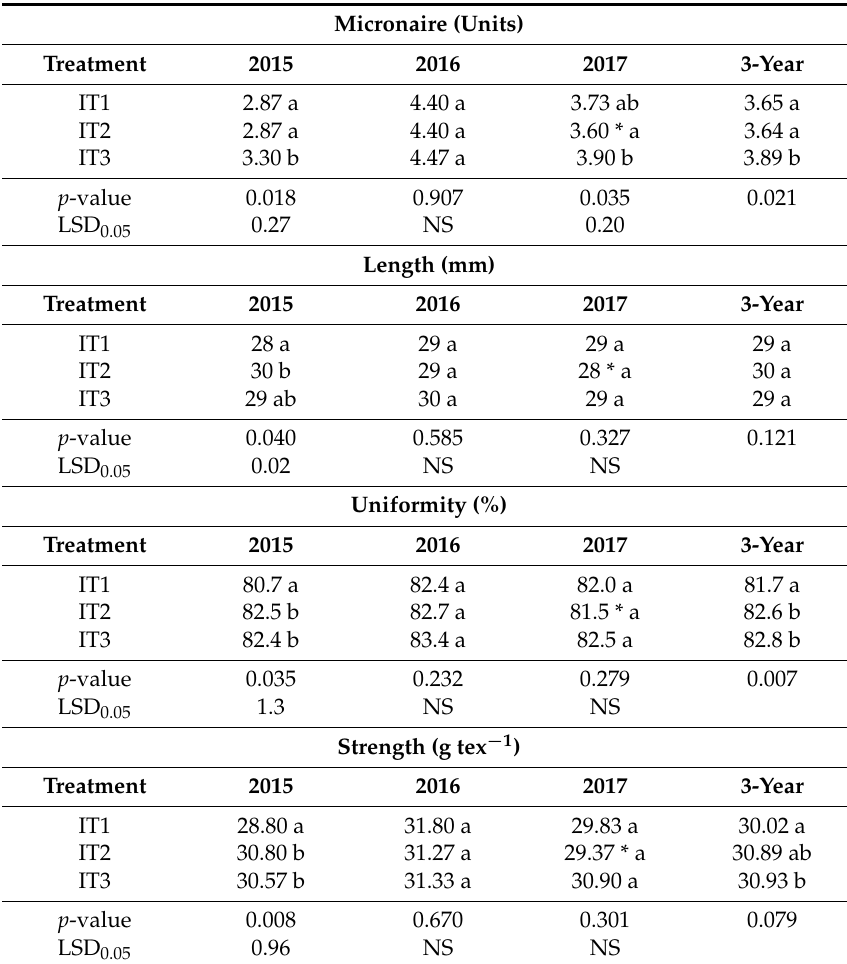
Table 6. Cotton HVI properties. Within each year, means followed by the same letter are not significantly different at the 0.05